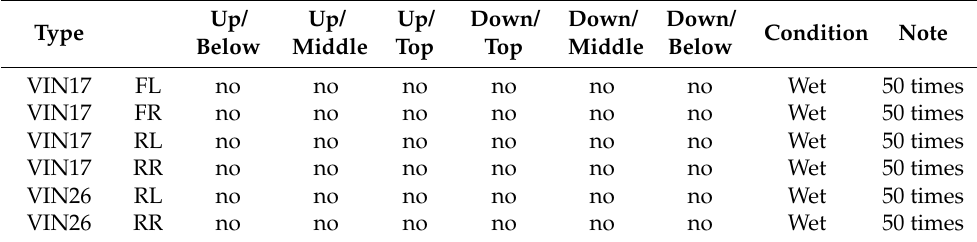
Table 6. Experimental